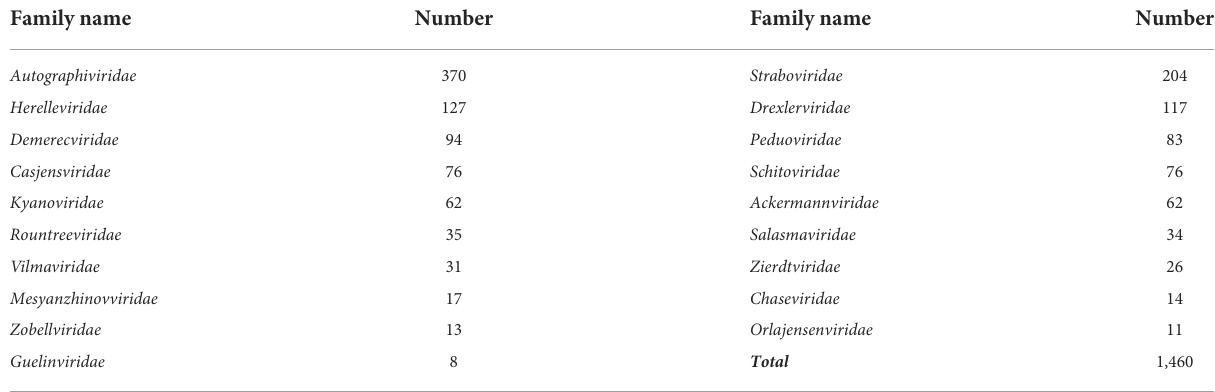
TABLE 3 The 19 families under class Caudoviricetes from the RefSeq database we used in the